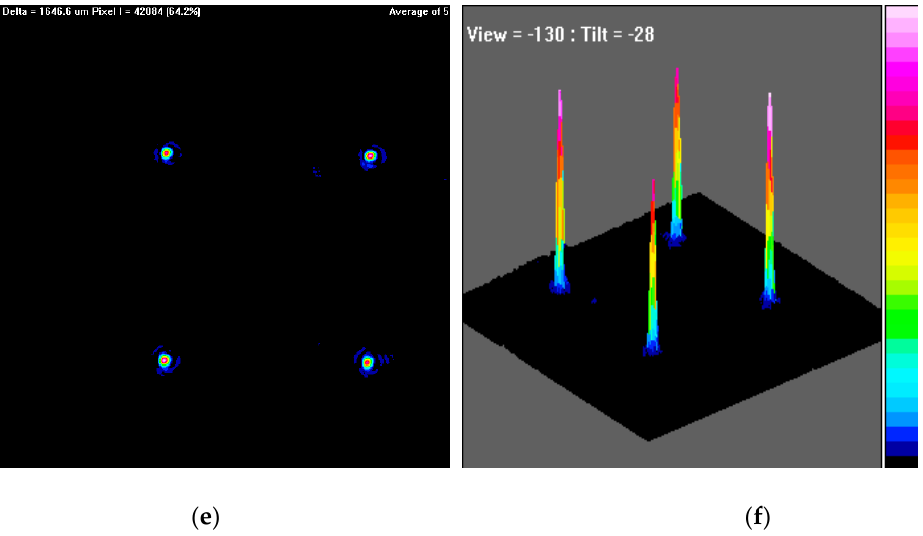
Figure 4. The light intensity distribution formed by LC micro-lenses. ( a ) The 2D light intensity distribution at 0 V rms at the distance of ~3.550 mm and ( b ) the 3D light intensity distribution at 0 V rms at the distance of ~3.550 mm. The 2D light intensity distribution at ~4 V rms at the distance of ( c ) ~2.215 mm, ( d ) ~2.555 mm, and ( e ) ~3.550 mm. ( f ) The 3D light intensity distribution at ~4 V rms at the distance of ~3.550 mm.